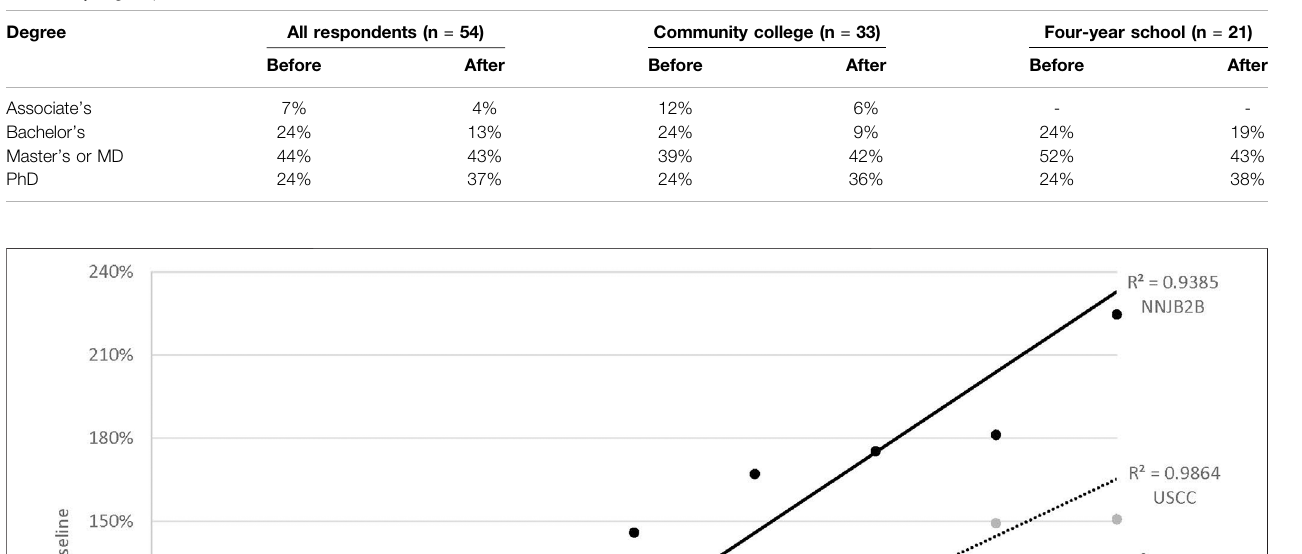
Frontiers in Education |